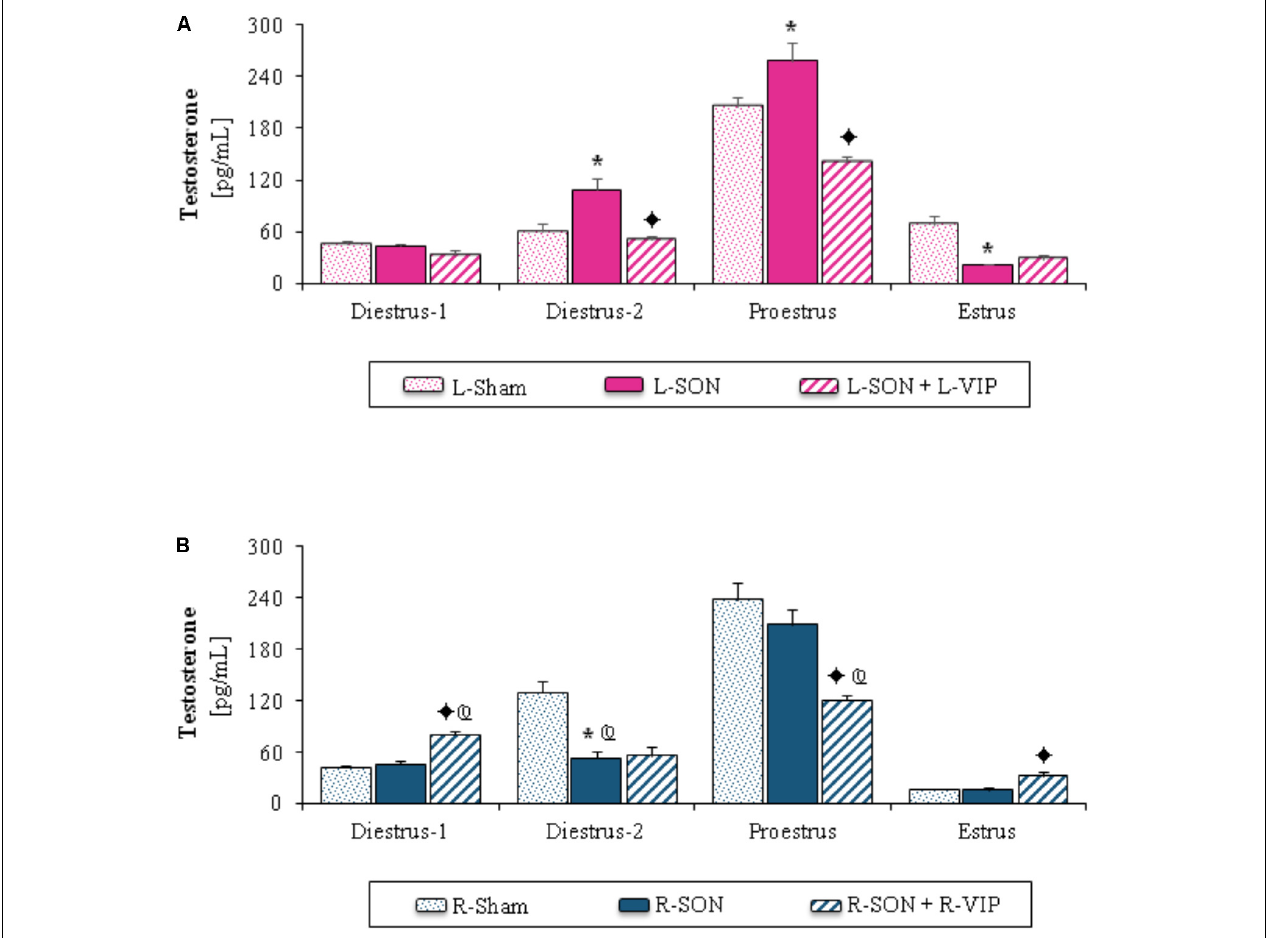
FIGURE 2 | Mean ± SEM of testosterone (pg/mL) serum levels in animals submitted to left (A) or right (B) sham surgery (L-Sham or R-Sham), or the left or right sectioning of the superior ovarian nerve (L-SON or R-SON) with or without subsequent treatment with VIP into the left or right denervated ovary (L-VIP or R-VIP). Animals were sacrificed 1 h after surgery. ∗ p < 0.05 vs. its respective L-Sham or R-Sham group; (cid:70) p < 0.05 vs. its respective L-SON or R-SON group; p < 0.05 vs. group with the same treatment of the left side (Student’s t